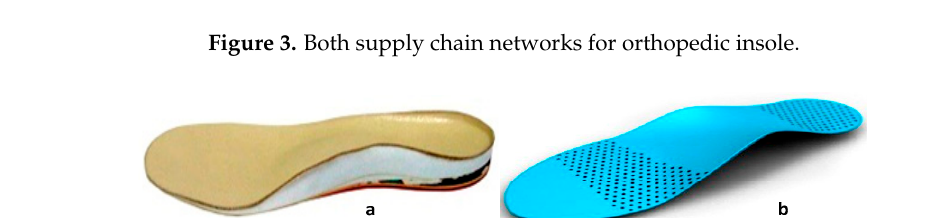
Figure 4. Orthopedic insoles manufactured by traditional method ( a ) and 3D printing ( b ).